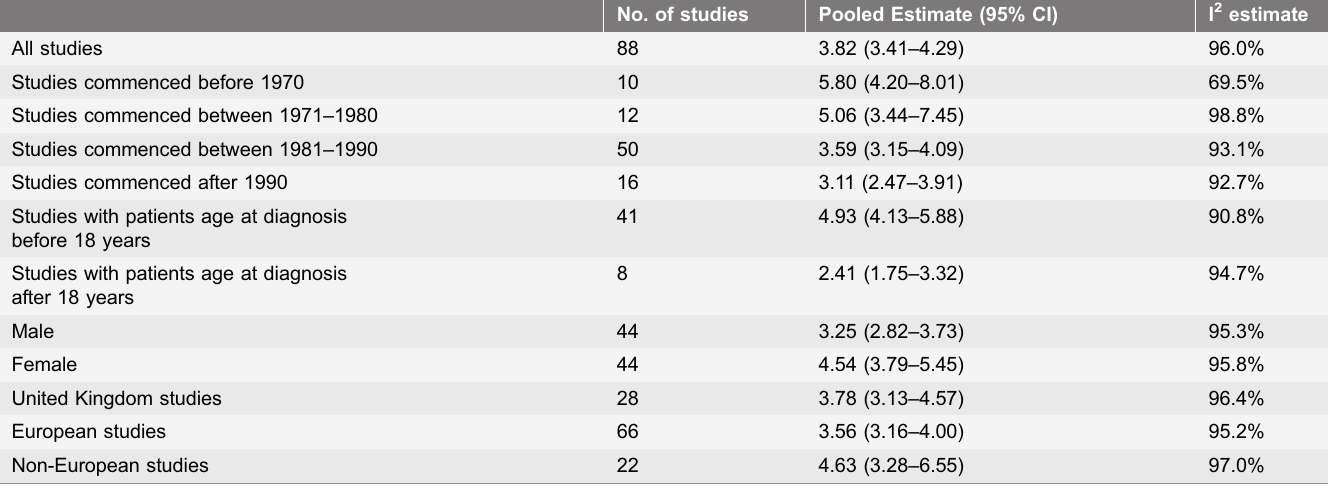
All sub-group meta-analyses results are also shown in Table 2. Fixed-effects inverse variance meta-analysis for all sub-groups found strong evidence of heterogeneity within sub-groups, and heterogeneity between sub-groups (p , 0.01). When conducting separate meta-analyses for men and women, RRs of death were 3.25 (95% CI 2.82, 3.73) and 4.54 (95% CI 3.79, 5.45), respectively. I- squared estimates of 95.3% (men) and 95.8% (women) showed similar Table 2. Meta-analysis results by different categories, showing the number observations used, the pooled estimate and 95% confidence intervals and I 2 estimate for heterogeneity. No. of